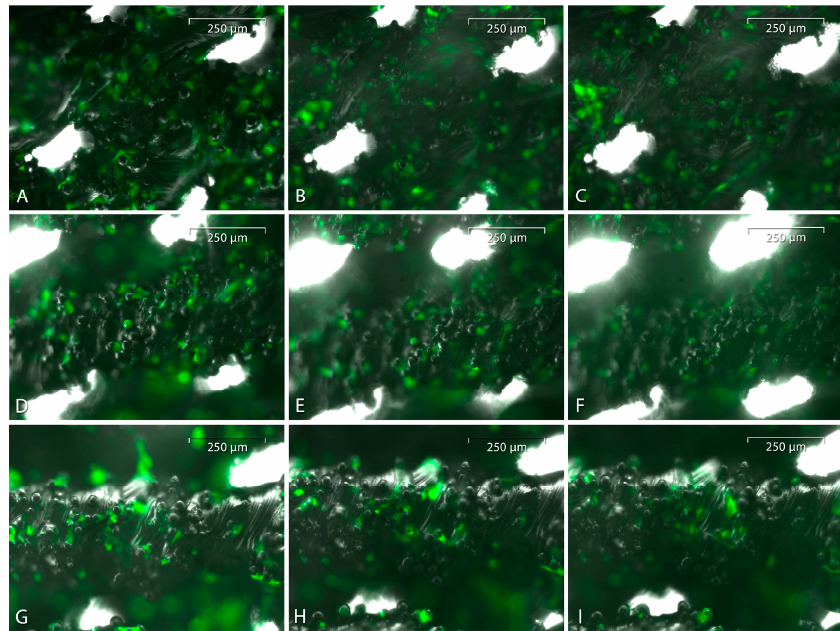
Figure 9. GFP-linked osteoblasts on an uncoated ( A – C ), PCL-coated ( D – F ) or P(3HB)-coated ( G – I ) titanium scaffold on day 0 ( A , D , G ), 3 ( B , E , H ) and 7 ( C , F , I ). The pictures were taken at a 10-fold magnification (scale bar: 250 µm).